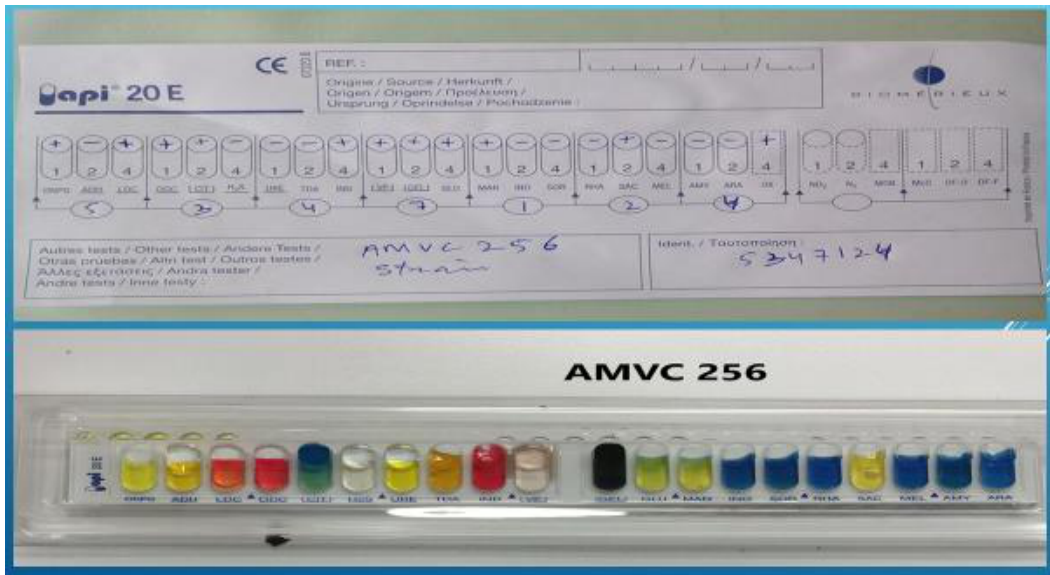
Figure 1: Identification of V. cholerae by Biotypic using API 20E